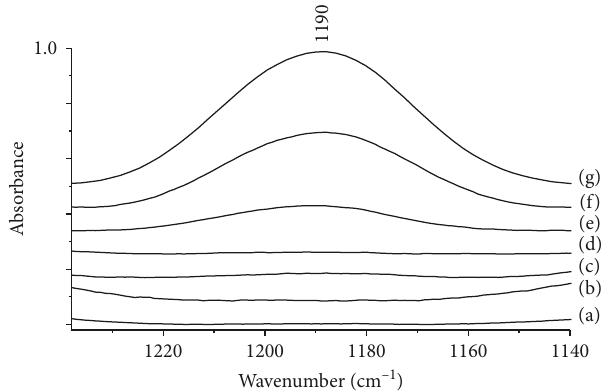
Figure 5: IR spectra of liquid FA and 0.5mol · kg − 1 salt solutions at the c HNH region: (a) solvent; (b) Zn(II); (c) Ni(II); (d) Co(II); (e) Fe(III); (f) Al(III); (g)